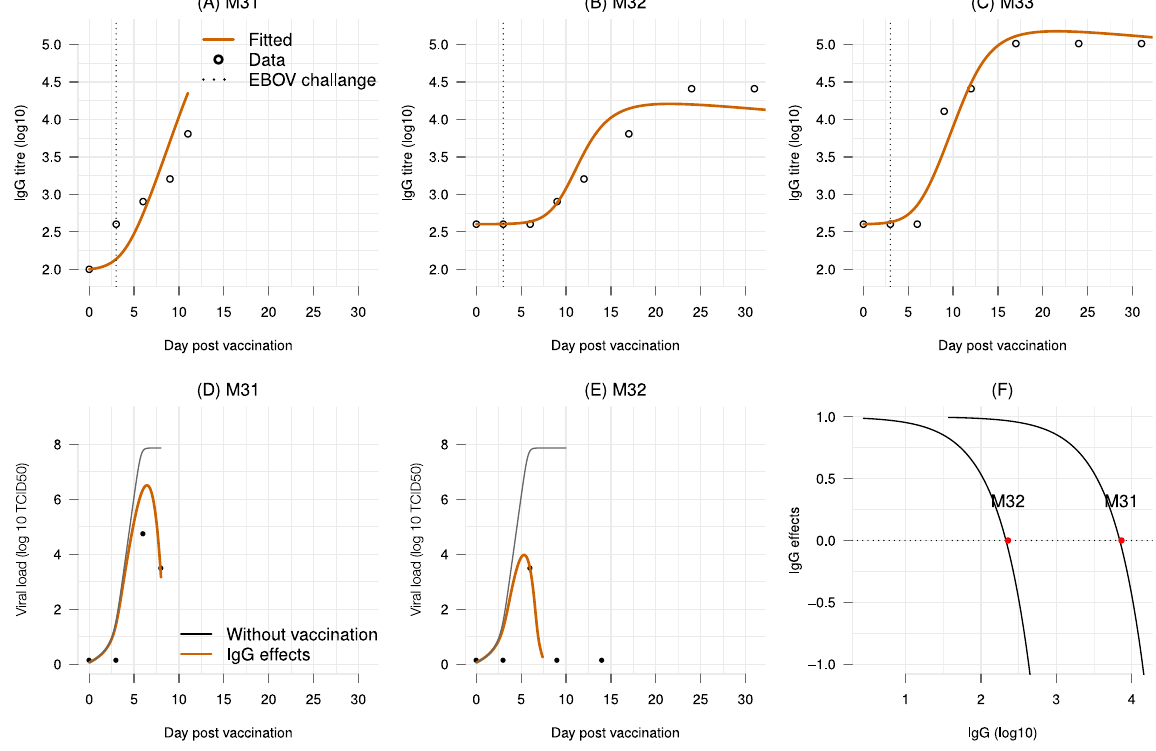
Figure 3. Effects of the IgG antibody on controlling viral load. ( A – C ) Fitting the IgG dynamic model Eqs (3)–(5) to the IgG data of the three subjects vaccinated three days before the EBOV challenge. Noting that the M31 had an exceptional low baseline IgG (100) while all other animals had a higher baseline (ranged from 200–400 with a mean of 269). ( D , E ) Fitting the viral dynamic model Eq. (6) to the viral load data of the two subjects vaccinated three days before the EBOV challenge. The model without vaccination (solid black line) is added as reference. ( F ) Functions of IgG effect on controlling viral growth in each subject.